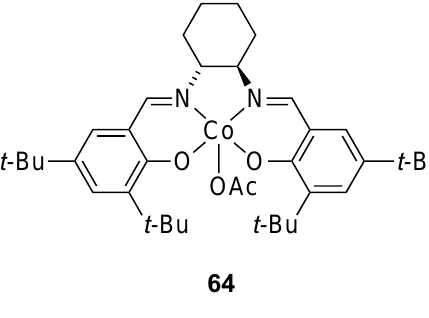
Figure 26. Co–salen complex 64 .